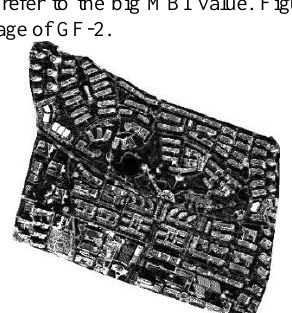
Figure3. MBI feature image of